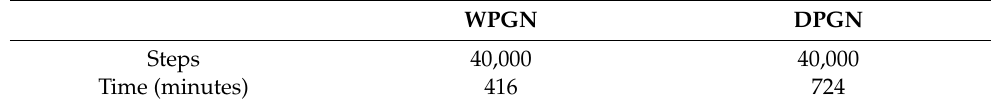
Table 8. Training time